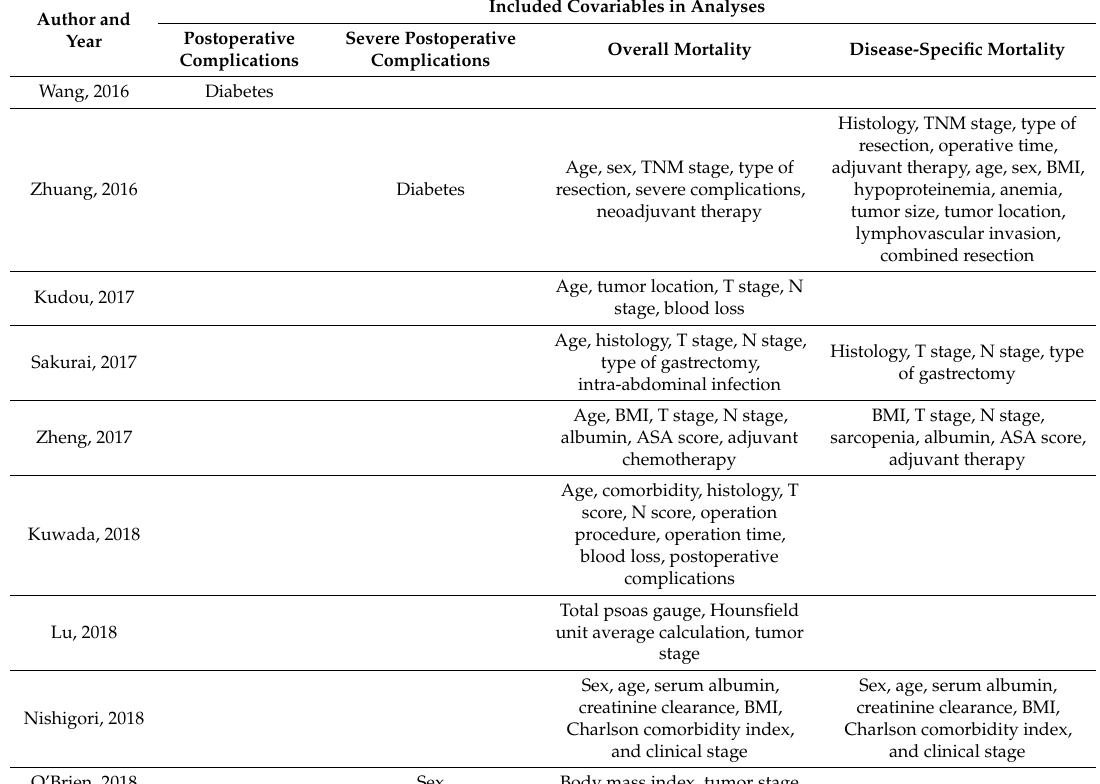
Figure 2. Overview of risk of bias of the included studies after Quality in Prognosis Studies (QUIPS) assessment. Table 2. Overview of covariables included in the multivariable analyses of the included studies per outcome (postoperative complications, severe postoperative complications, overall mortality, disease ‐ specific mortality).